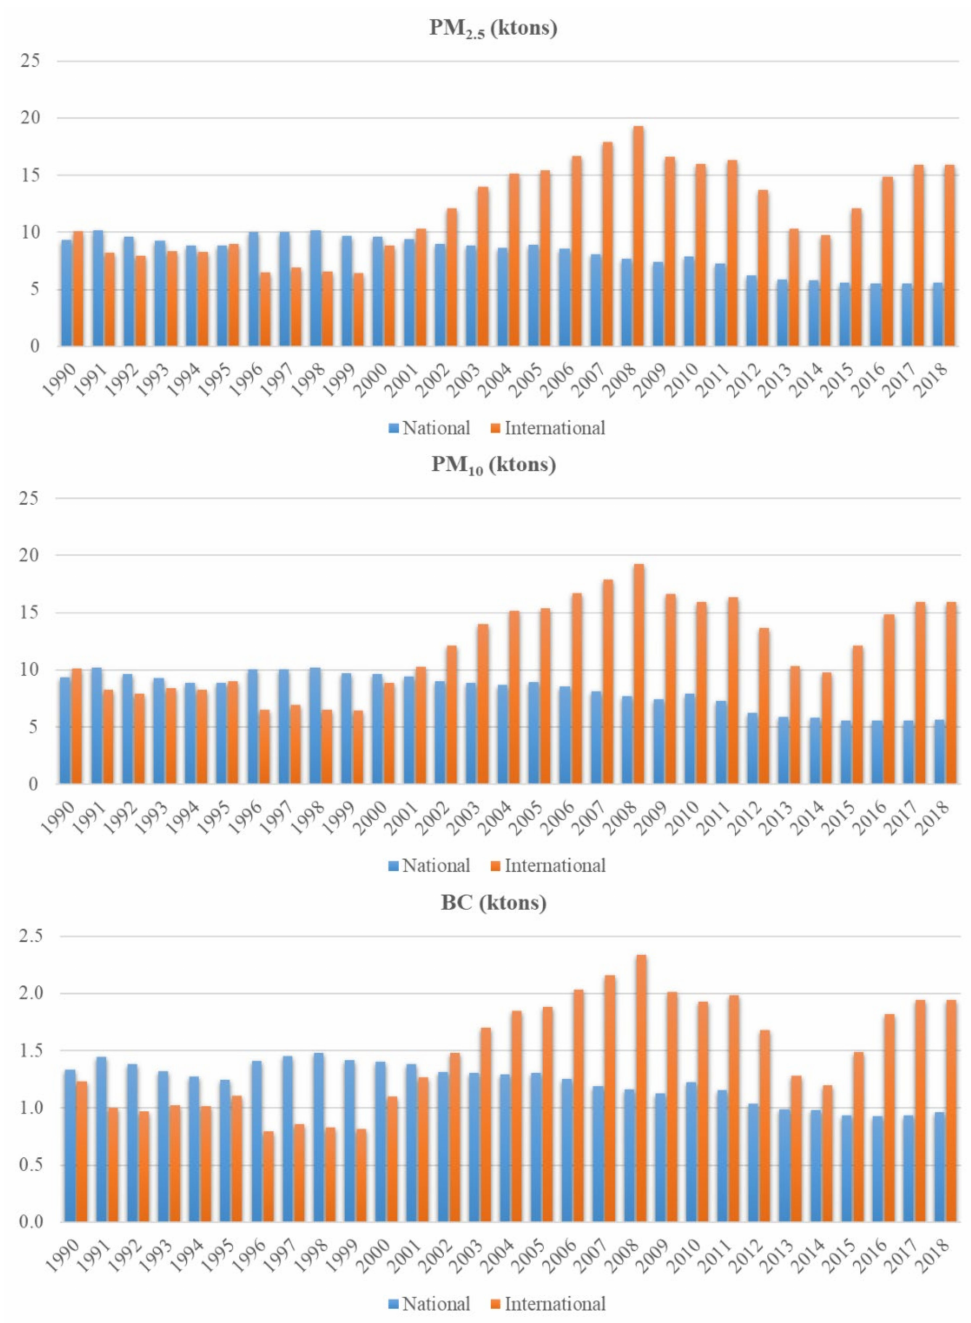
Figure 4. PM and BC emissions of national and international shipping, reported in the Italian emission inventory in the 28-year period 1990–2018. Data from ISPRA elaborations [91]. Concerning other ship categories, some commercial harbours could represent the majority in terms of gross tonnage and number of ships (i.e., ferries, cargoes). Italy has four leading hubs: Gioia Tauro, Genoa, La Spezia, and Trieste, in three different important areas and commercial networks. Emissions of different vessel categories and for each operation phase were computed in several studies in Italian harbours with activity-based methodologies, then represented as input for model simulations. Total emissions of NO X , PM 10 , SO 2 , CO and NMVOCs were calculated in some Italian harbours in different studies and ad-hoc projects by applying EMEP/EEA methodology (Figure